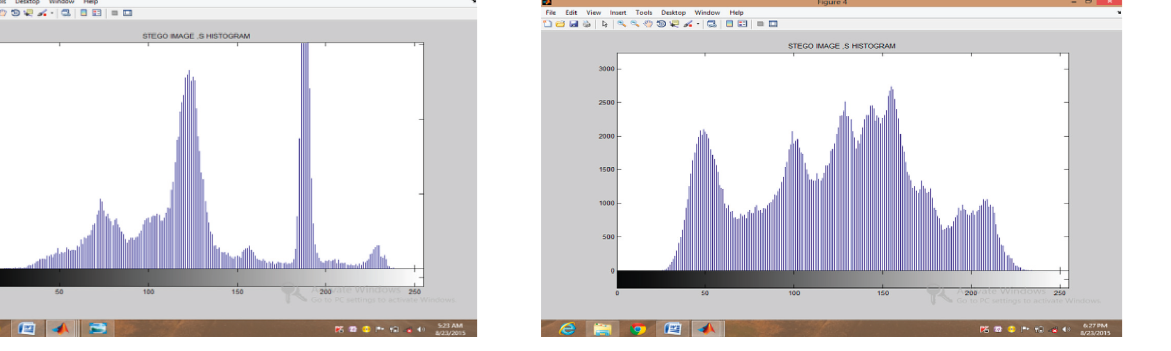
Figure 22: Histogram of stego image of